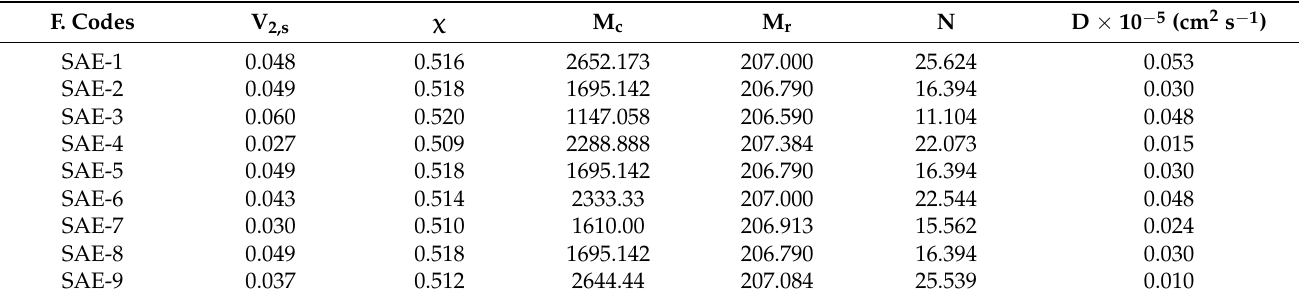
Table 2. Flory–Huggins network parameters of SA-g-AMPS